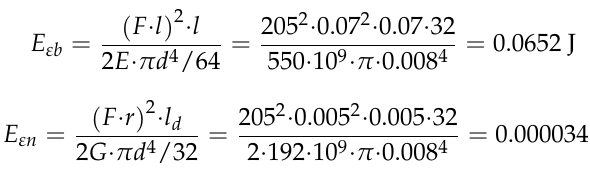
Figure 6. Cycles of the combined displacement of the cutter in the X and Y directions.